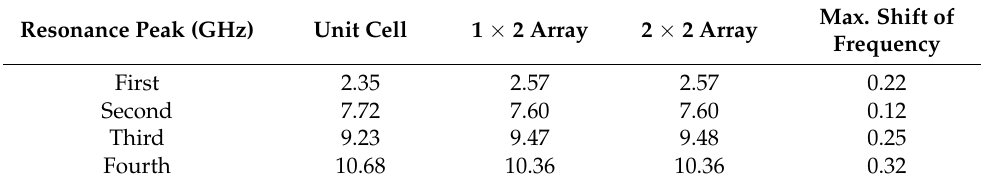
Figure 18. Comparison of S parameters for a array and unit cell ( a ) transmission coefficient ( S 21 ) and ( b ) reflection coefficient ( S 11 ). Table 4. Deviation of frequency for various arrays of unit